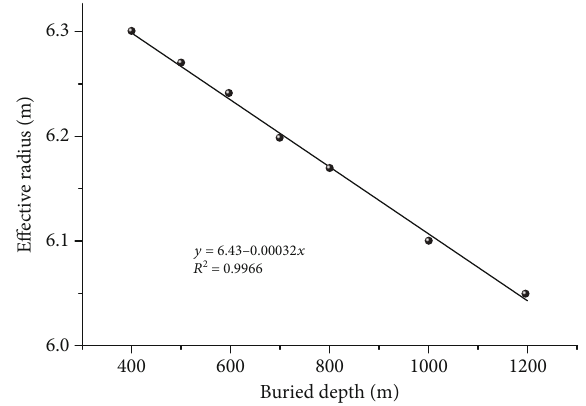
Figure 12: Relationship between initial permeability and e ff ective radius ( 1 mD = 1 × 10 − 17 m 2 ).